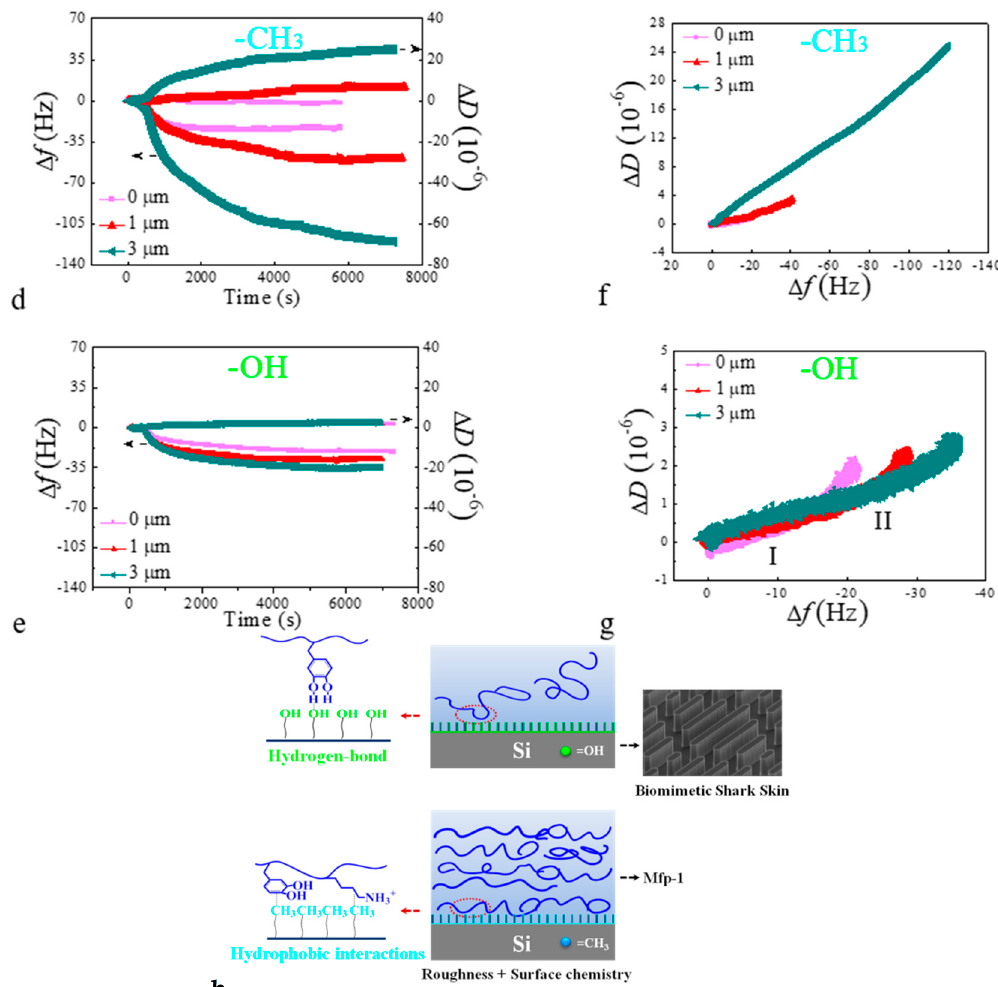
Figure 3. ( a )–( c ) Schematic illustration of the fabrication procedure of the hierarchical structure on quartz crystal microbalance with dissipation (QCM-D) sensor; Changes in frequency ( Δ f ) and dissipation ( Δ D ) as a function of time for the adsorption of Mfp-1 on the ( d ) CH 3 -terminated and ( e ) OH-terminated surfaces; Δ D / Δ f plots for the adsorption of Mfp-1 in the case of ( f ) CH 3 -terminated and ( g ) OH-terminated surfaces; and, ( h ) A schematic of adhesion mechanisms. For simplicity, only the curves of Δ f and Δ D versus time at the third overtone are shown here.